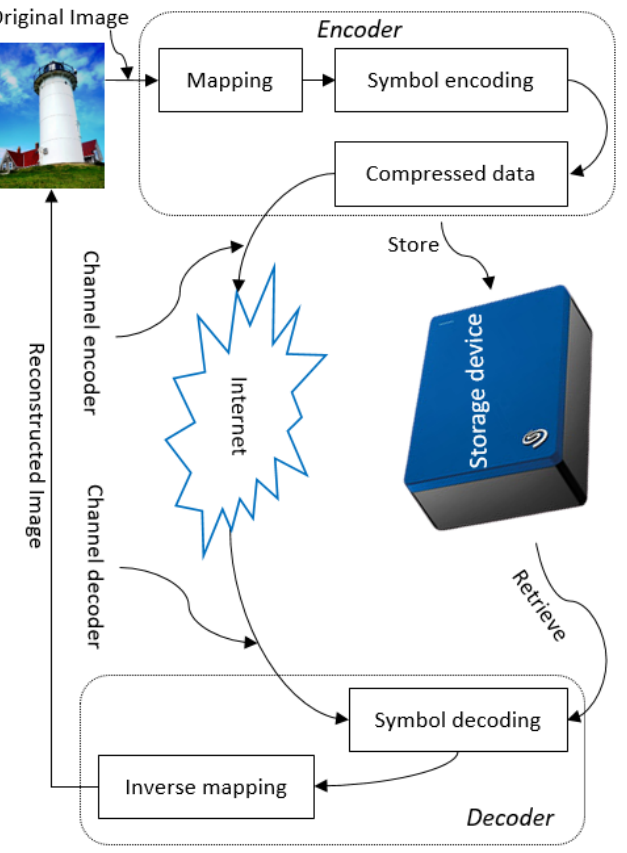
Figure 8. Basic block diagram of lossless image